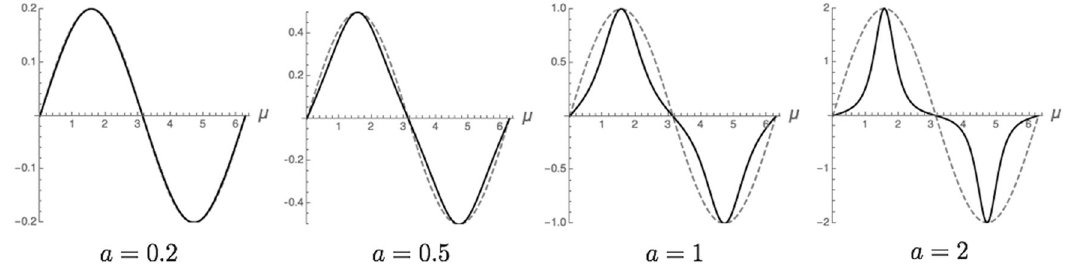
Fig. 1 Sine wave curvatures and capillary non-linearity. Comparison of dimensionless in-plane curvatures [solid curves from Eq. (2)] shown with their pro fi les (broken curves). Pro fi les are plotted non-isometrically. Note the scale change on the ordinates with increasing amplitude, a Higher harmonic content of the curvature distribution is nearly absent at low wave amplitudes, a < 0.5, but increases rapidly as wave amplitudes exceed ca. a >